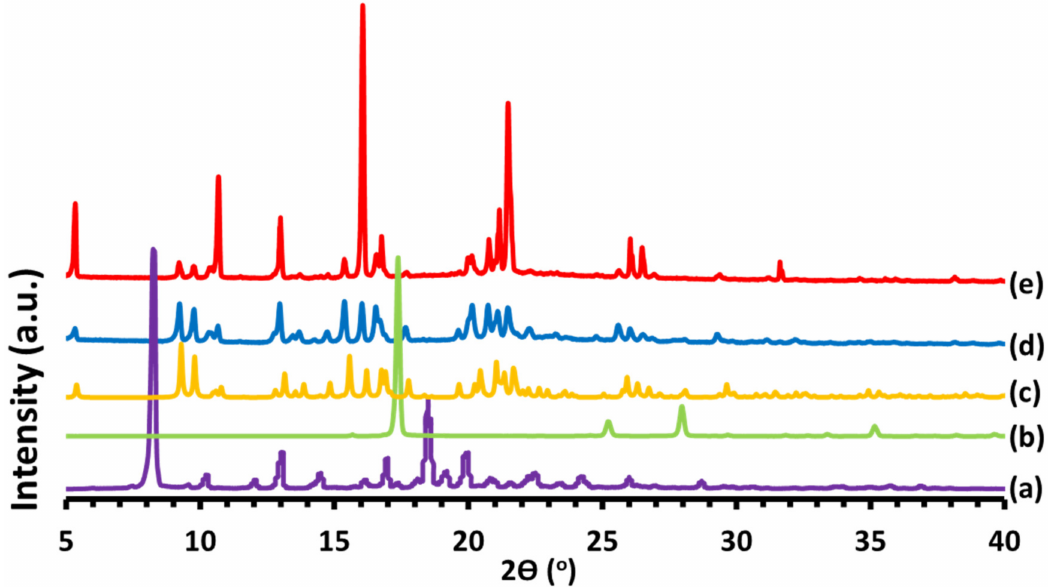
Figure 7. Powder X-ray diffraction (PXRD) patterns of ( a ) commercial DPA, ( b ) TA, ( c ) simulated DPA:TA, ( d ) DPA:TA salt obtained from slurry method, and ( e ) DPA:TA salt obtained from slow solvent